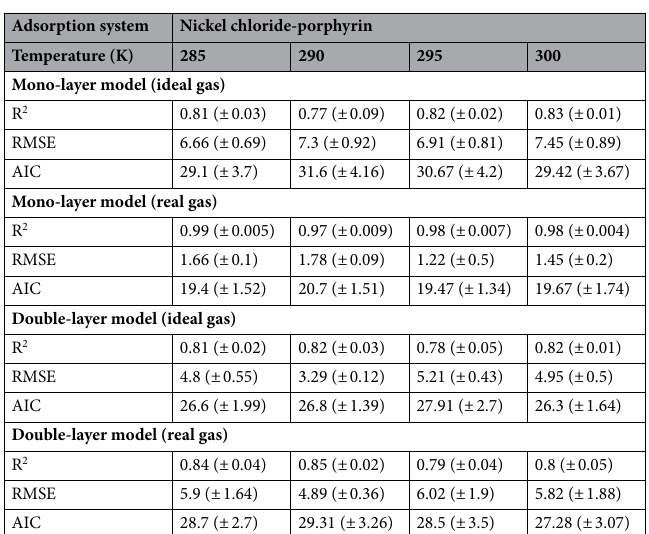
Table 3. Values of the correlation coefficient R 2 , the residual root mean square coefficient RMSE and the Akaike information criterion AIC deduced from the numerical adjustment of experimental isotherms of NiCl 2 on 5,10,15,20-tetrakis(4-methylphenyl) porphyrin with the four statistical physics models.